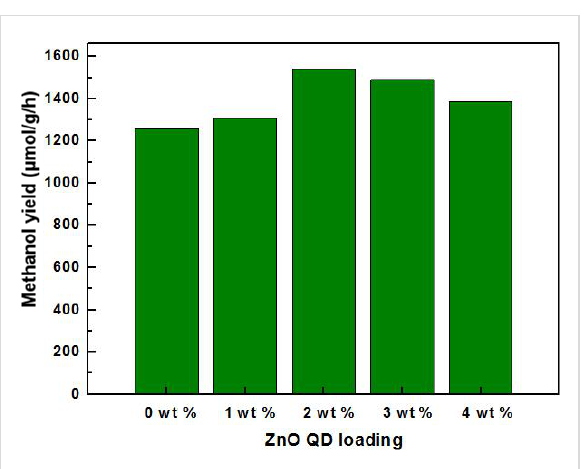
Figure 9: Trials showing the recyclability of the 2 wt % ZnO quantum dot/KNb 3 O 8 nanosheet composite